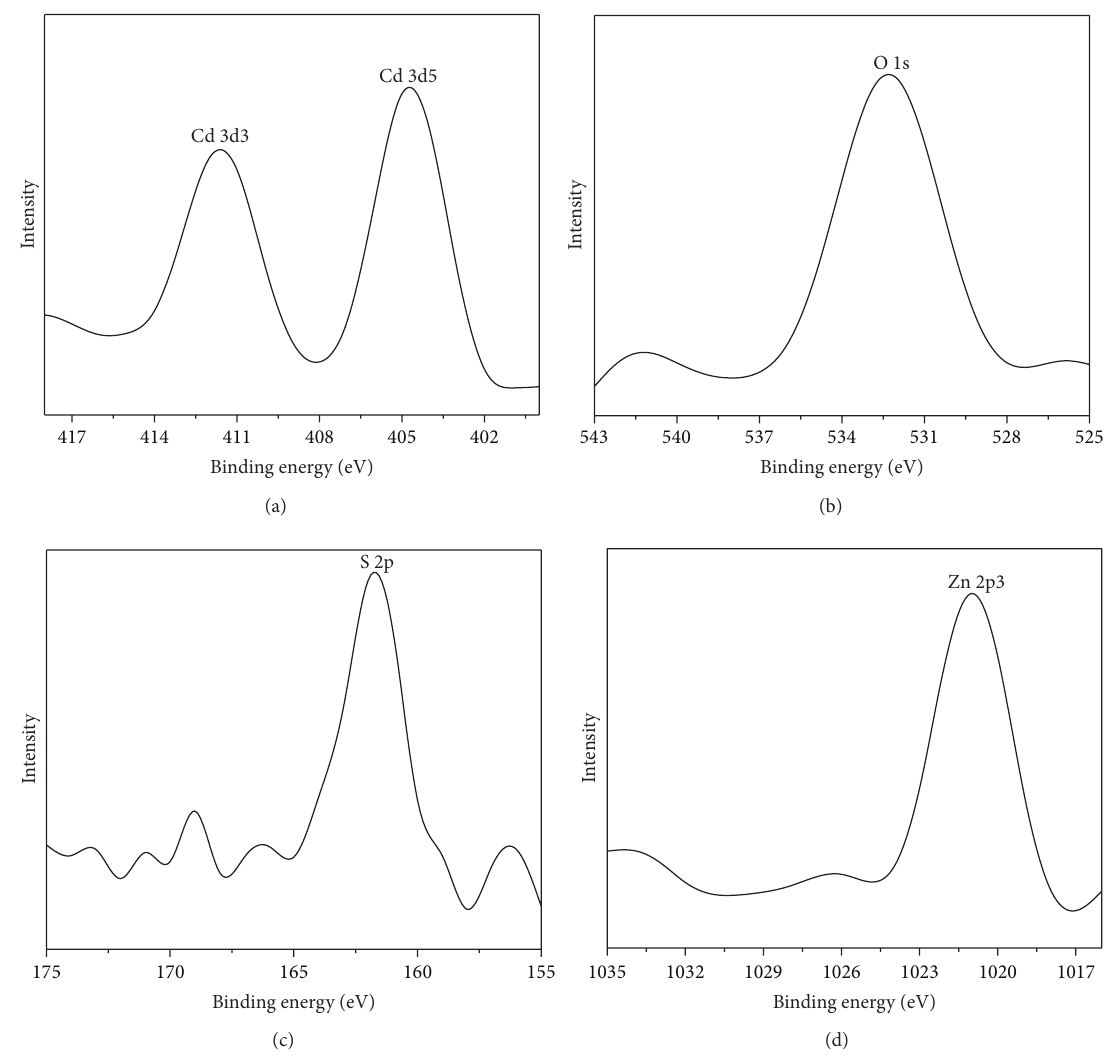
Figure 7: Narrow spectrum of (a) Cd, (b) O, (c) S, and (d) Zn, elements in ZnO/CdS/BC hybrid fiber